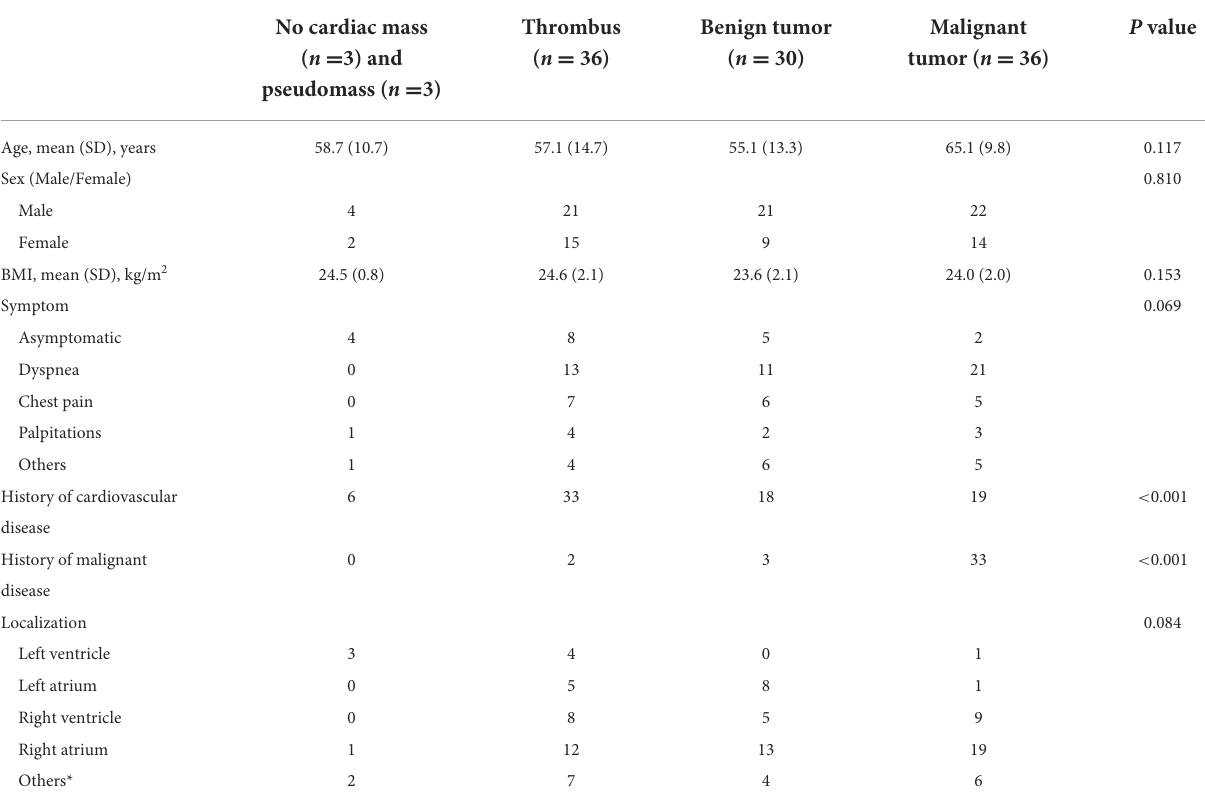
TABLE 1 Characteristics of the